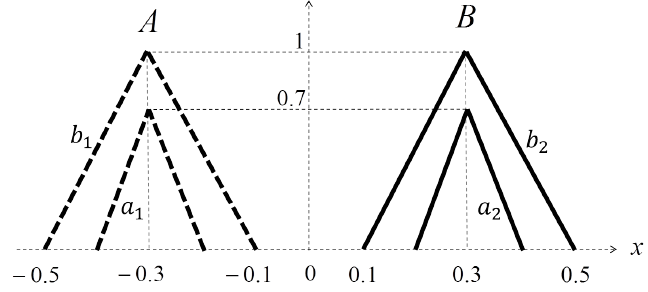
Figure 12. Support of two IT2GFNs A and B , with the functions a 1 , b 1 , a 2 , b 2 .